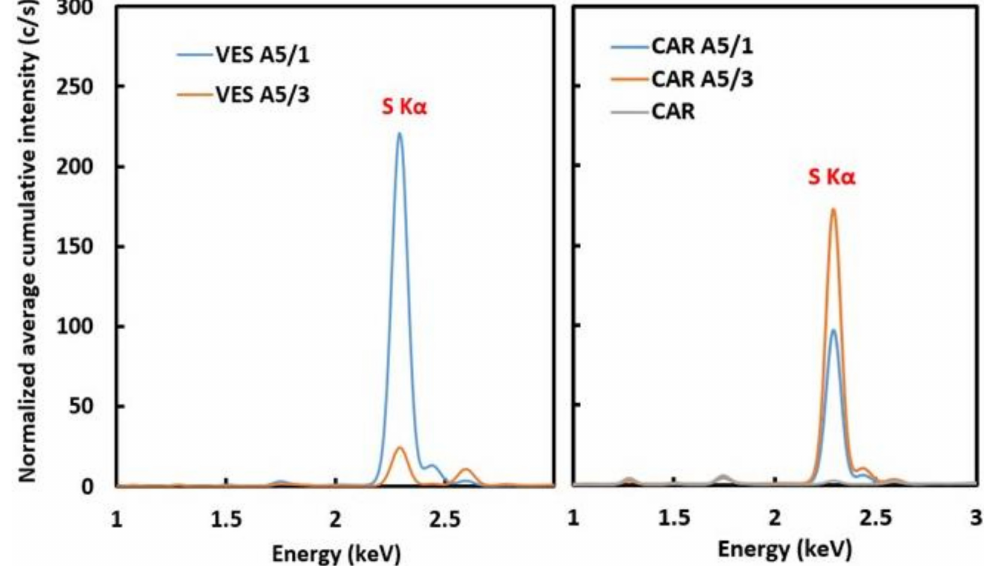
Figure 5. Cumulative XRF spectra showing count rates (c/s) for S-K X-rays for the 1 (A5/1) and 3 h (A5/3) brushing treatment of Veselje limestone ( left ) and Carrara marble ( right ) A negligible amount of sulfur present in untreated marble is also shown